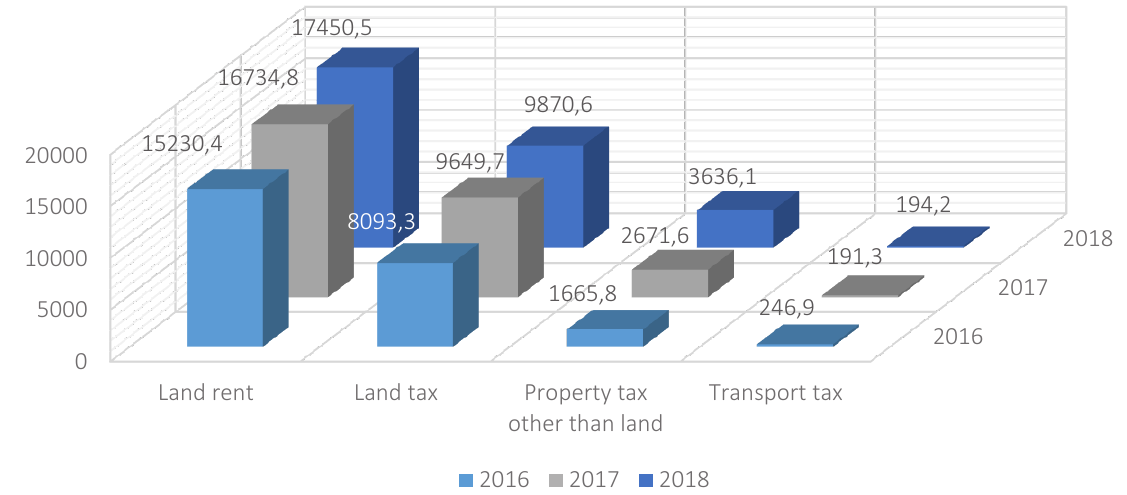
Figure 4. Changes in the structure of property tax receipts to local budgets of Ukraine for 2016–2018, UAH